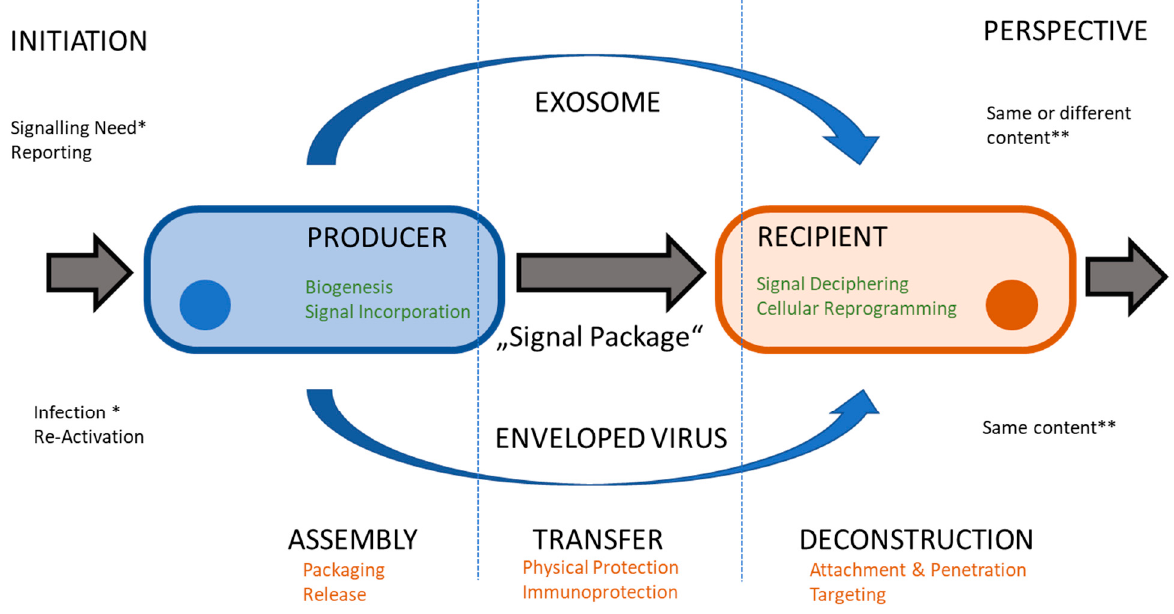
Figure 2. Comparing lifecycles. Both exosomes and virus particles transfer a package of signals from a producer cell to recipient cell. Cellular contribution (in green) and membrane functions (in orange) are similar, whereas initiating events (*) and perspectives (**)